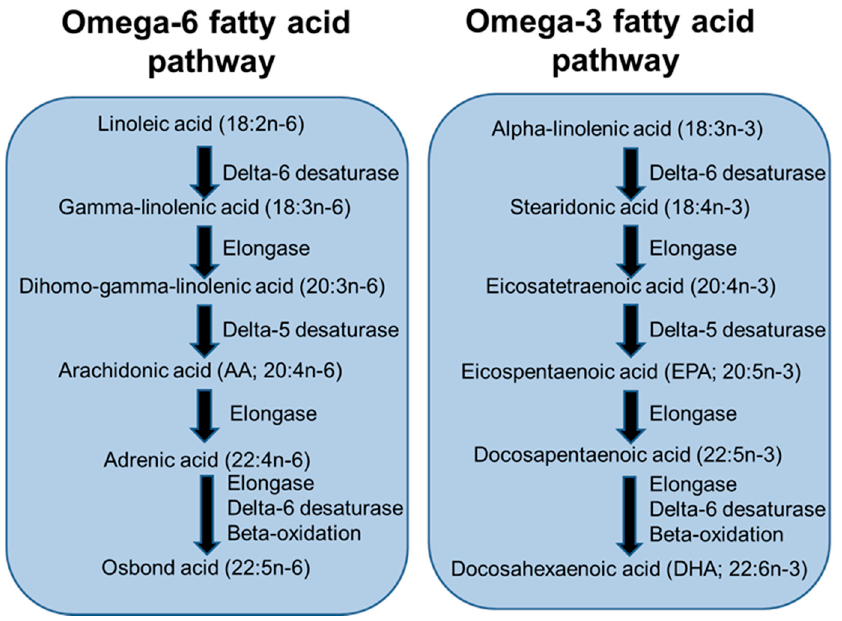
Figure 3. Pathway of long-chain polyunsaturated fatty acid (LCPUFA) biosynthesis from essential fatty acid precursors.